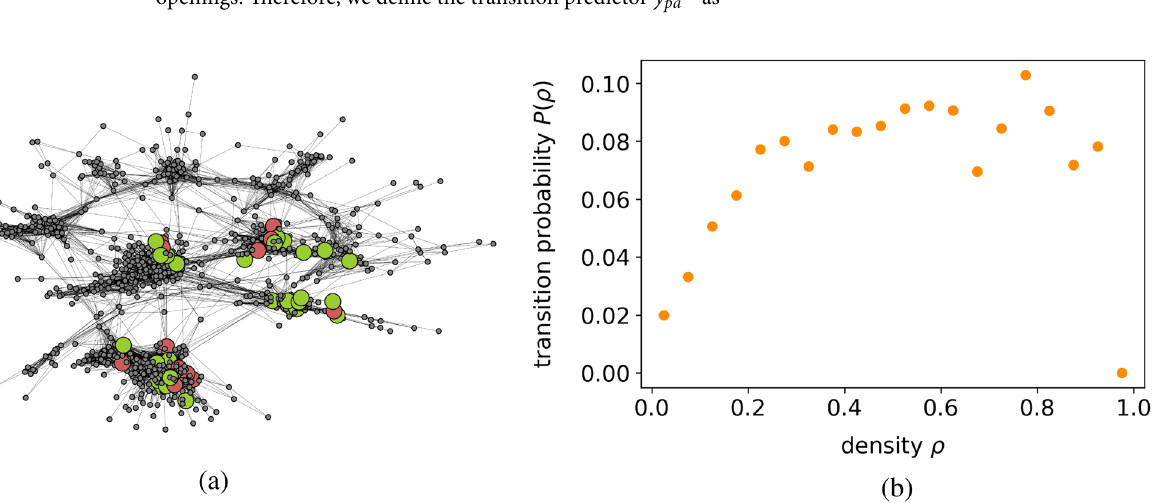
Figure 2. Prediction of future openings. ( a ) We plot, on the top of the opening network of Fig. 1, the openings a randomly selected player used during the period July 2016-September 2016 (green nodes) and the new openings he/she used in the period October 2016-December 2016 (red nodes). As it is possible to see, new openings are close to those openings the player already used. ( b ) Probability for a never used opening to start to be played as a function of its density, defined as the fraction of neighbour openings the player already uses. This probability is increasing in density, meaning players tend to learn openings close to those they already know. The network topology defines